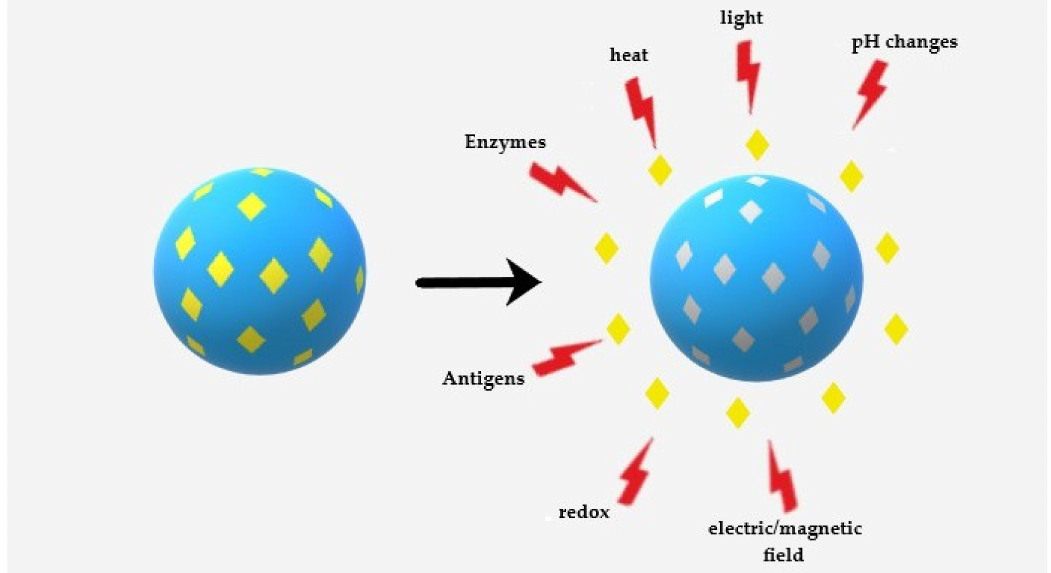
Figure 1. Stimuli-sensitive release of the cargo upon applying specific release triggers. The polymeric network can be designed to become remotely controllable through sensitivity to such external